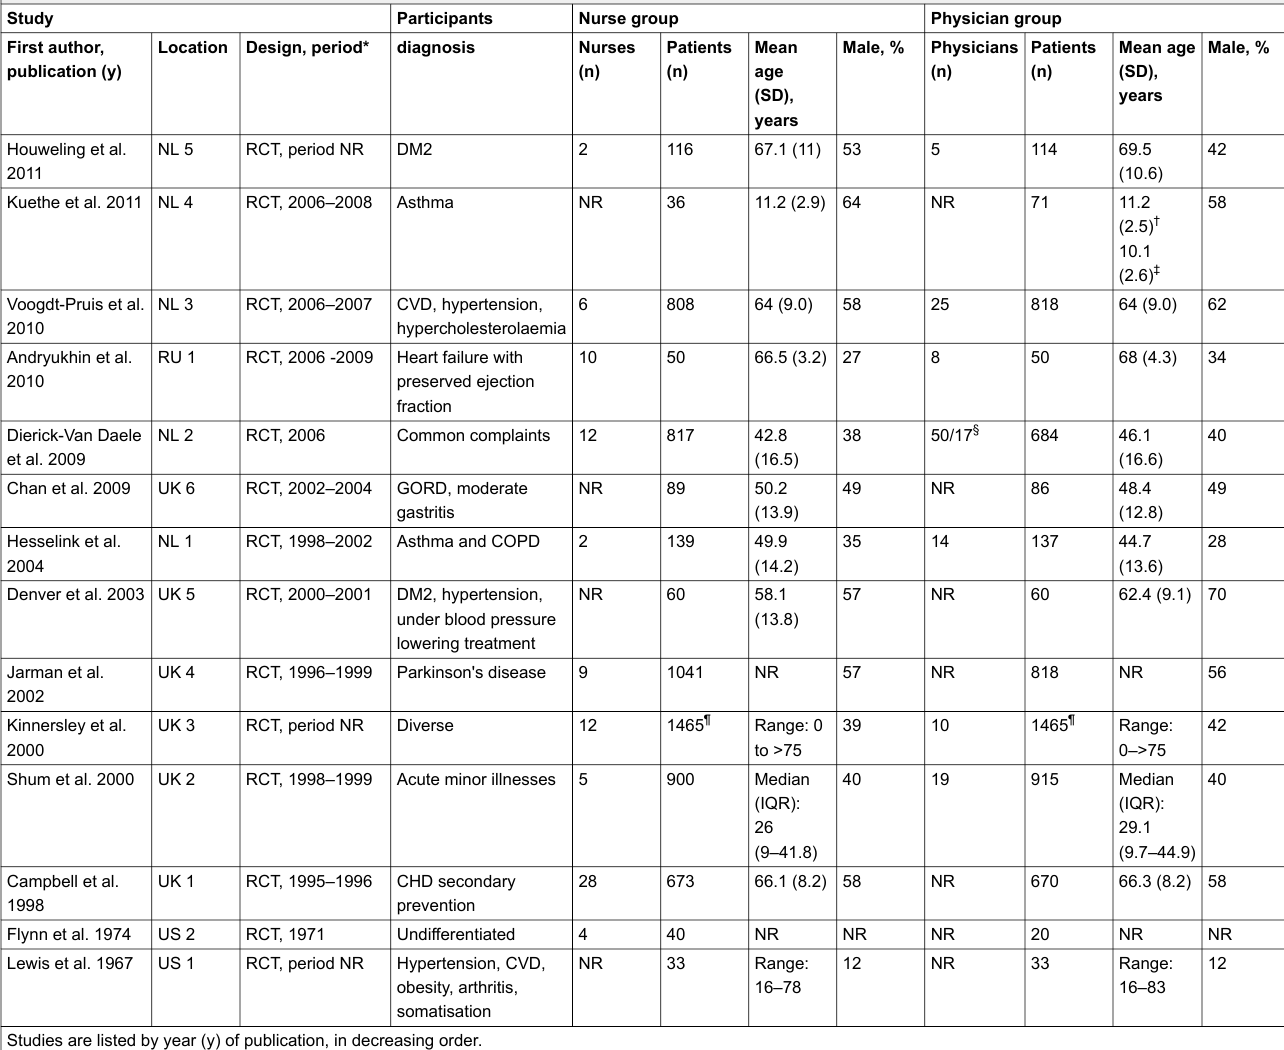
Table 1: Summary of study and population characteristics of studies included in